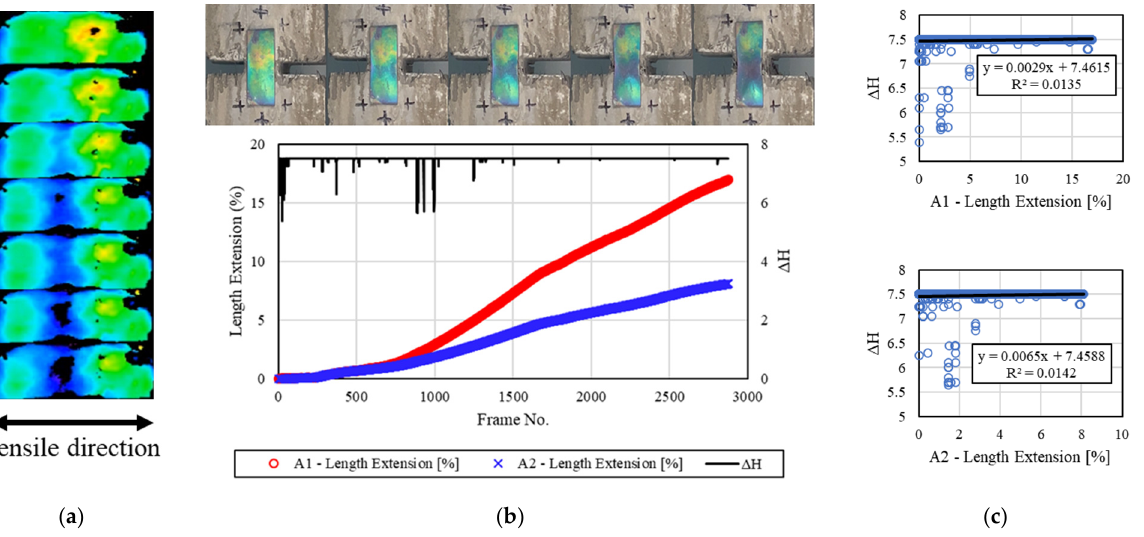
Figure 9. Results for the specimens after 2.0 h. ( a ) H-value image for discoloration color of mechanochromic sensor (90° rotation relative to tensile direction); ( b ) variations in strain and dH of A1 and A2 according to image frame. (The discoloration process of the mechanochromic sensor attached to the specimen and the tensile strain described in Figure 3 are shown.); ( c ) correlations of dH with A1 and A2.